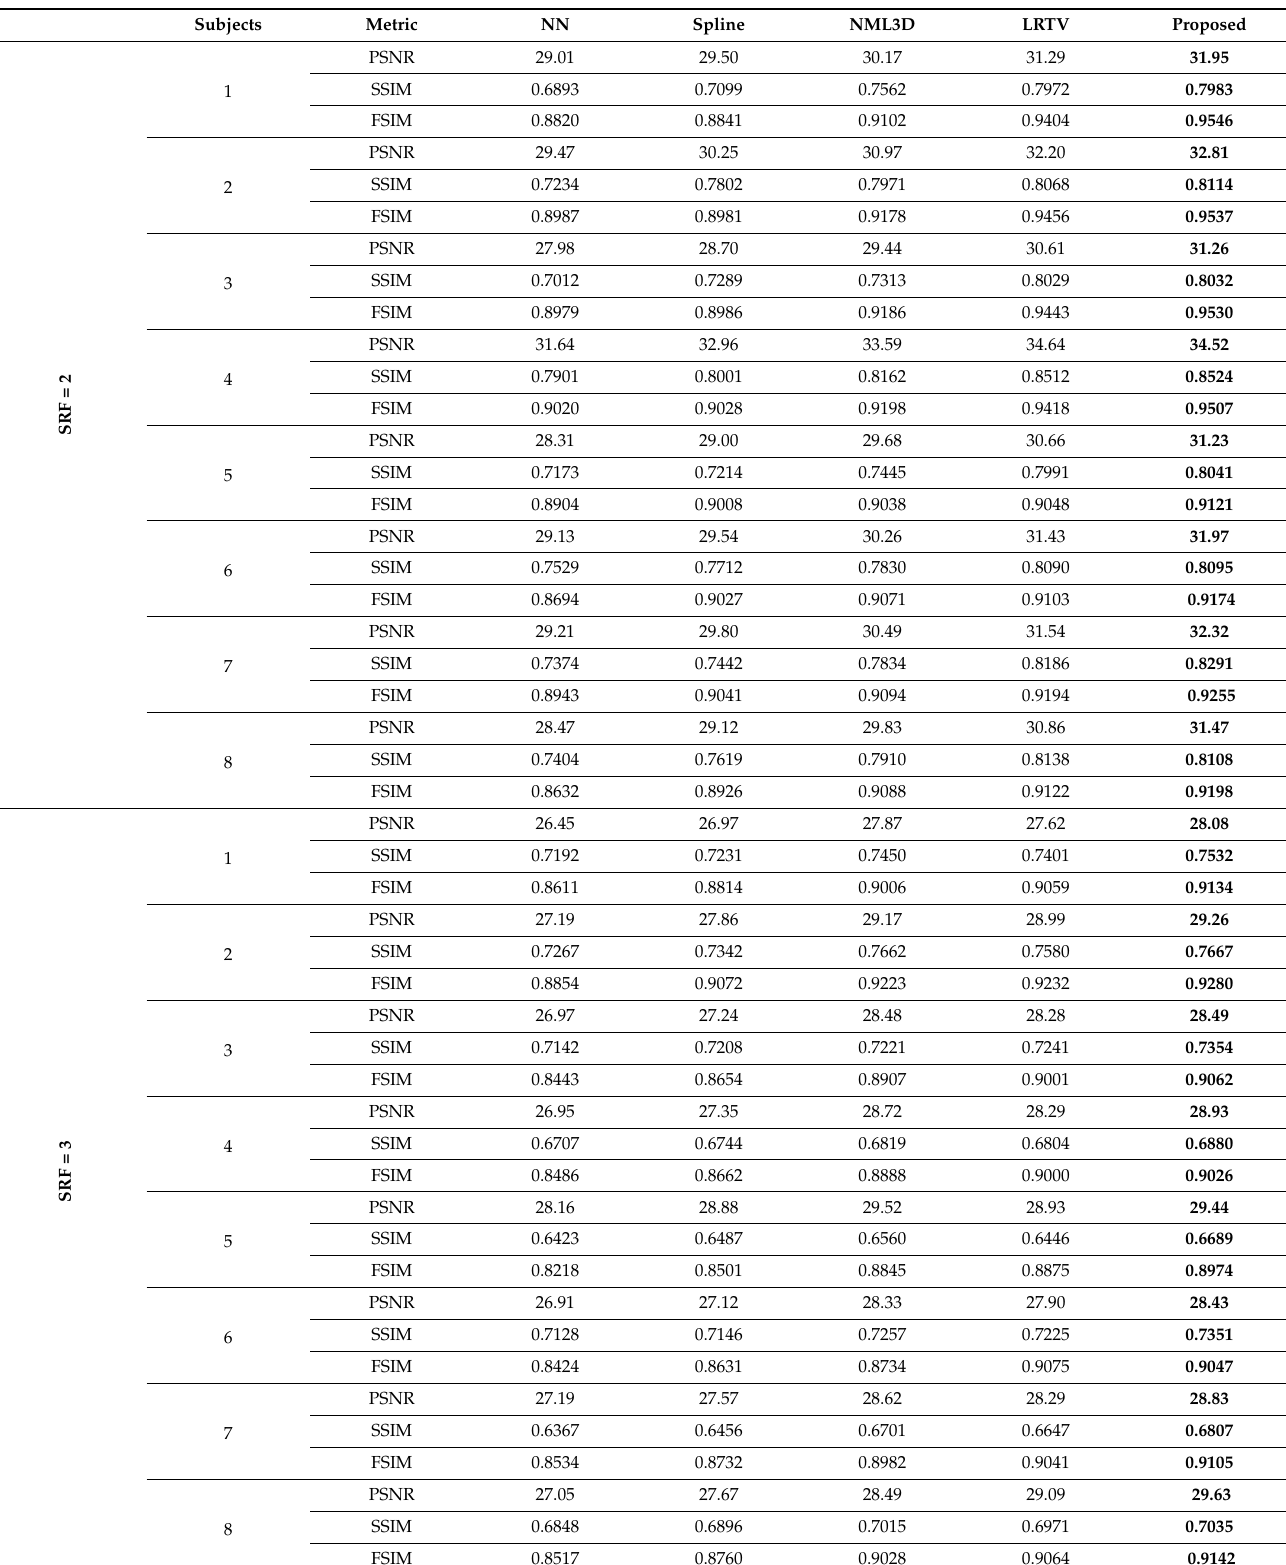
Table 3. Quantitative results for different algorithms for super resolution of real MR images with upscaling factors 2 and 3, degraded with synthetically added 2%